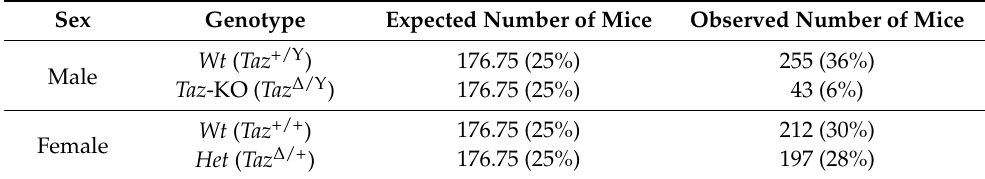
Sex Genotype Expected Number of Mice Observed Number of Mice Wt ( Taz +/Y ) 176.75 (25%) Male